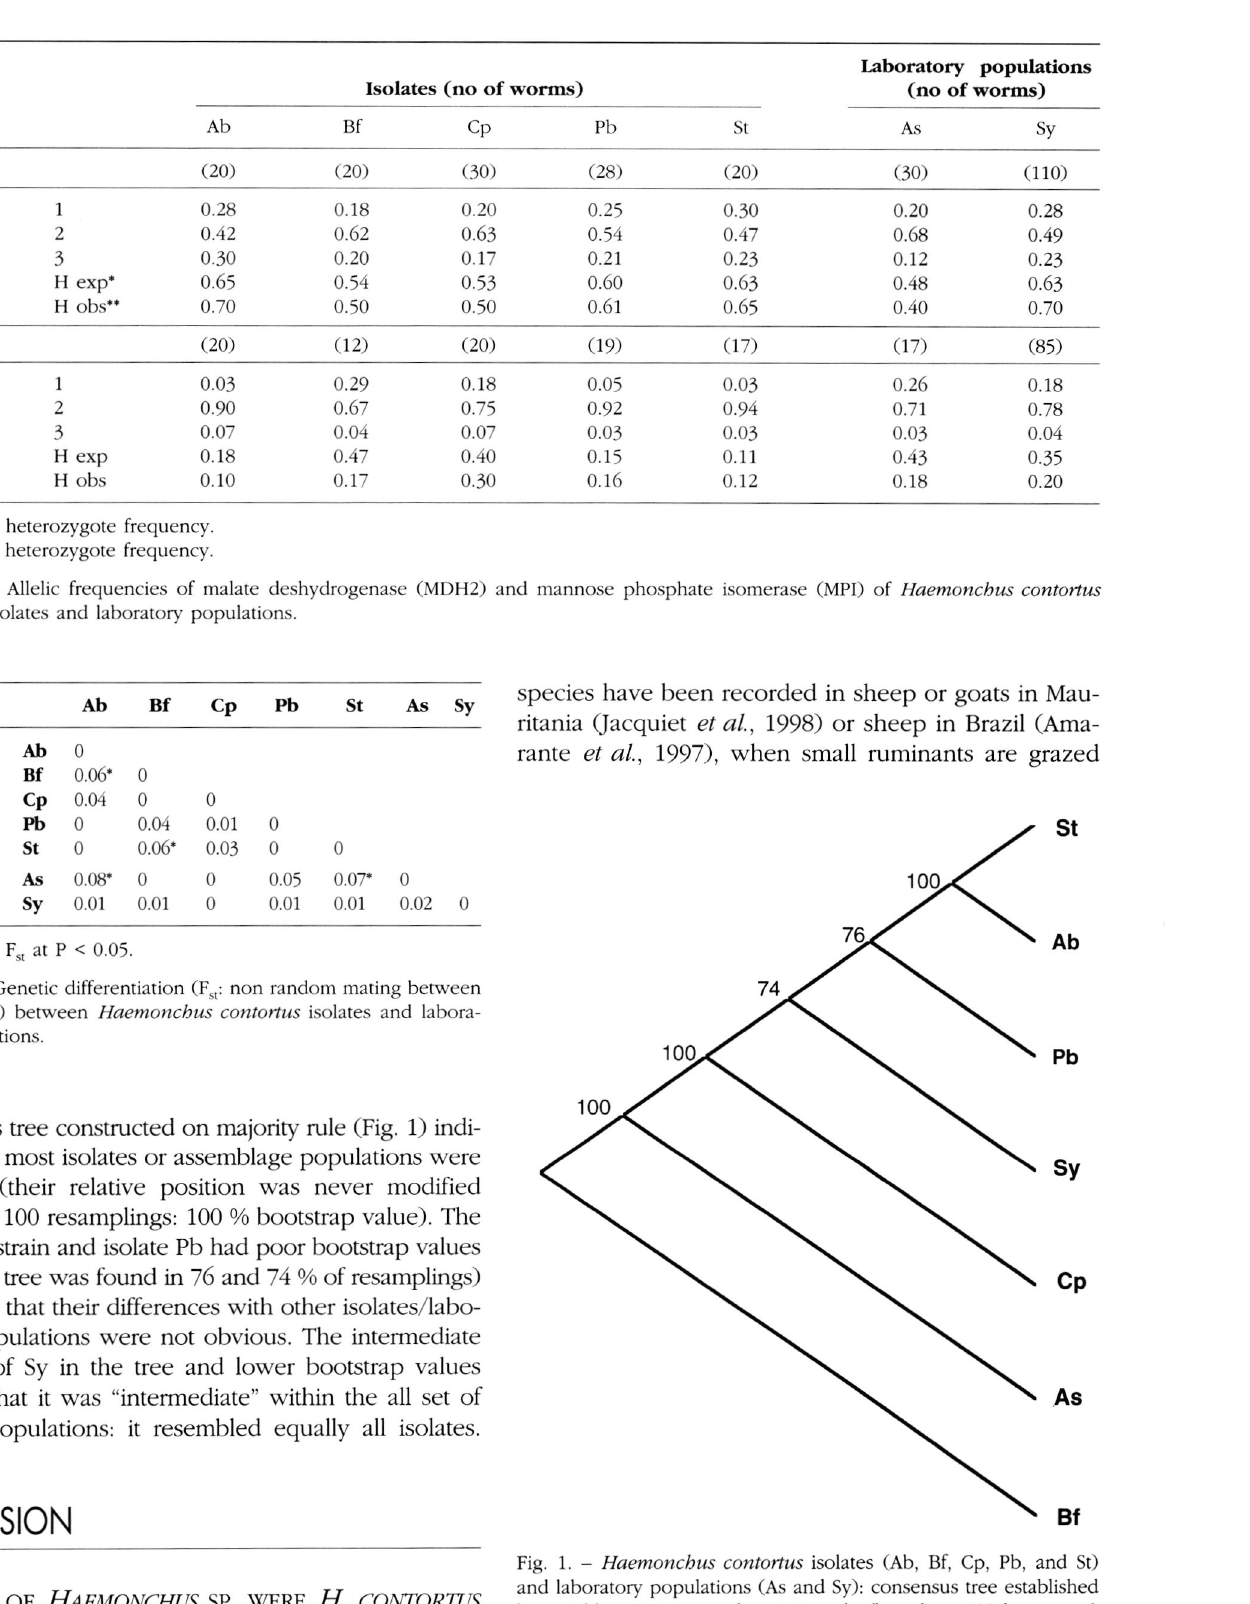
Fig. 1. - Haemonchus contortus isolates (Ab, Bf, Cp, Pb, and St) and laboratory populations (As and Sy): consensus tree established by neighbour-joining and majority-rule (based on 100 bootstraps) of Reynolds distance based on allozyme study (Malate dehydroge nase and Mannose phosphate isomerase). The figures represent the percentage of resamplings that indicates the same position in the tree for isolates or laboratory